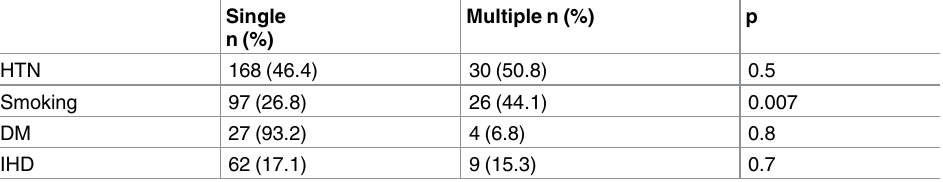
Table 3. Comparison of the aSAH risk factors and comorbidities between aSAH patients with single and multiple intracranial aneurysms.